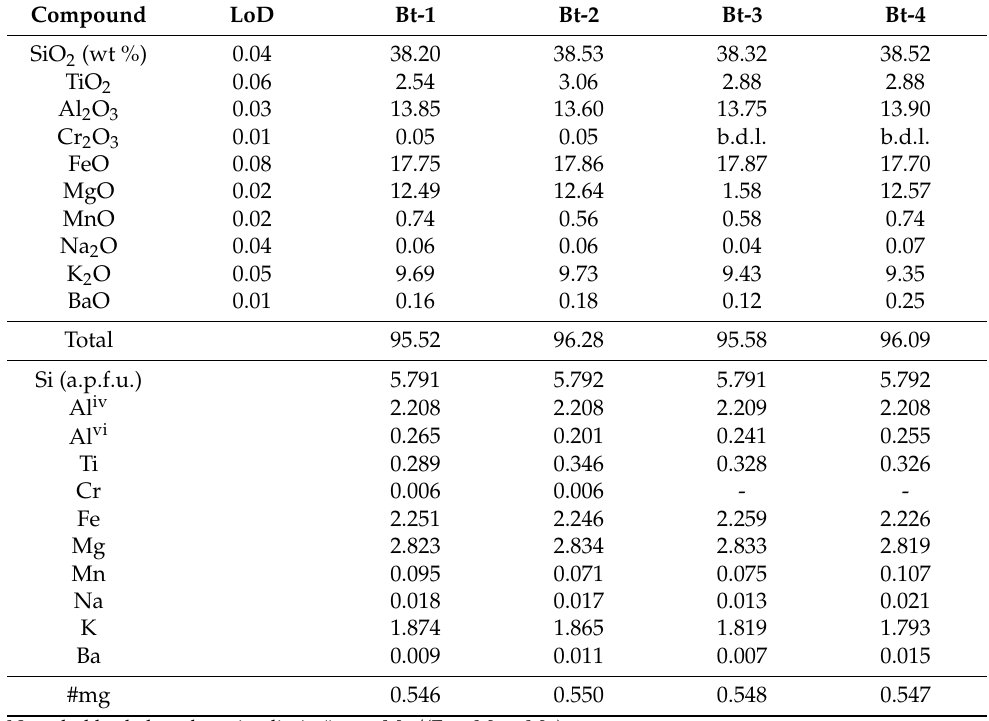
Table 1. Representative electron microprobe analyses (EMPA) of biotite crystal and their chemical formulae calculated on the basis of 22 O 2 − .